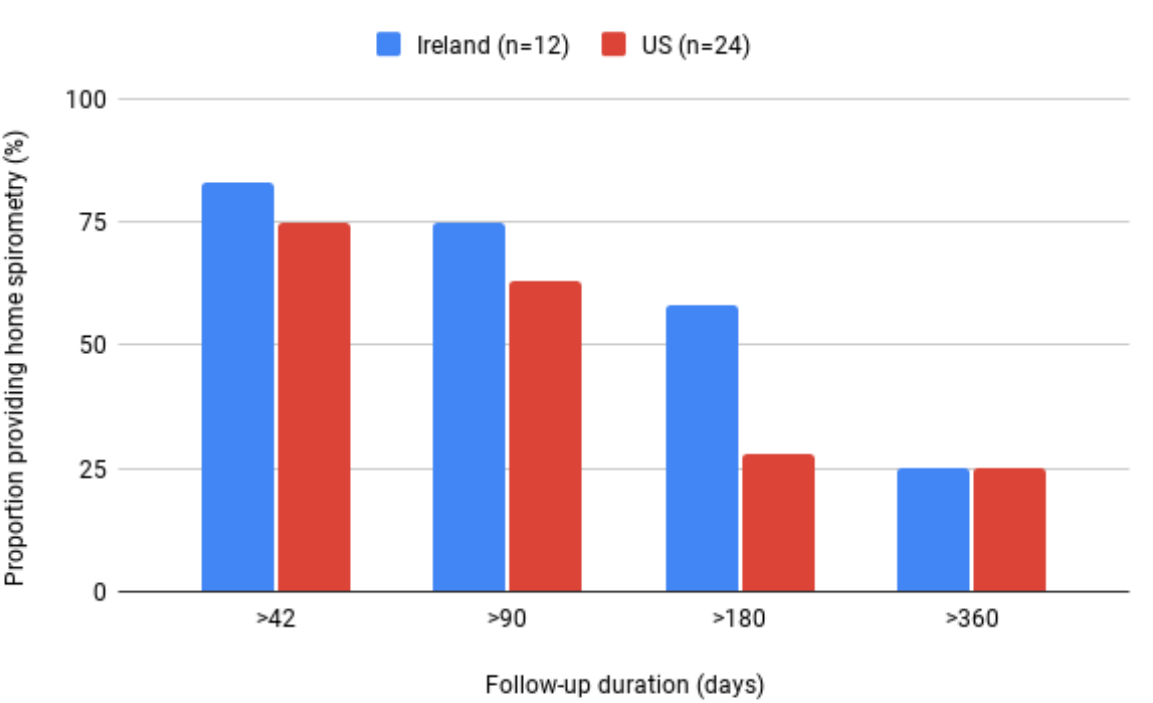
Figure 1. The proportion of participants from the Ireland and US studies recording home-based spirometry at least once against the duration of follow-up. Proportion of participants providing home-based spirometry data at each follow-up duration calculated relative to total numbers of participants who provided any spirometry data in that population. US: United